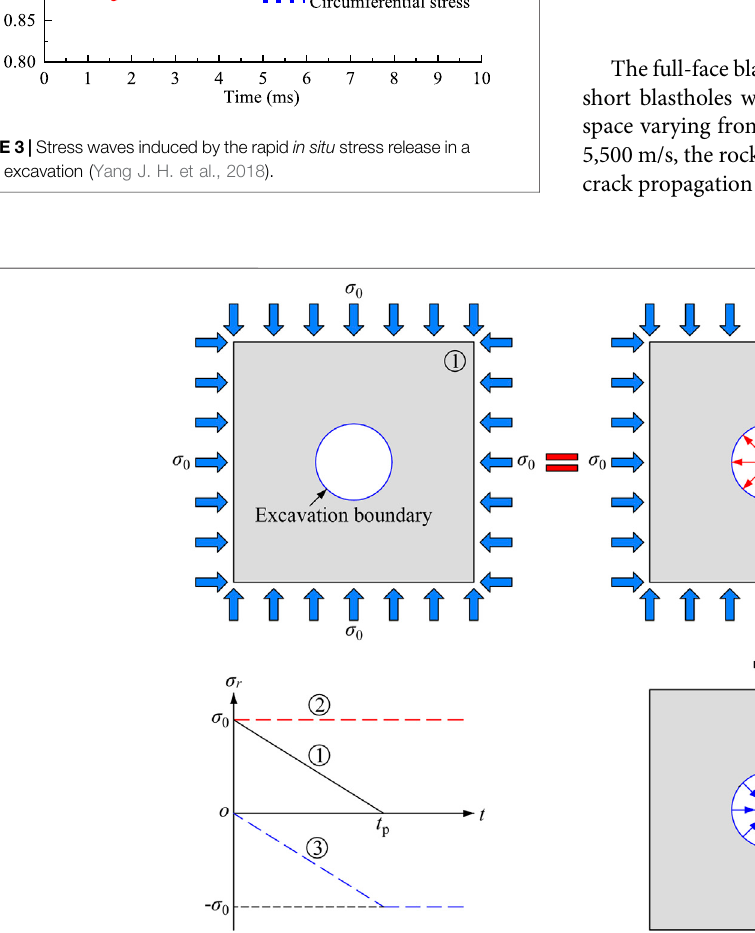
FIGURE 4 | Equivalent model of a circular excavation under a hydrostatic in situ stress fi eld.